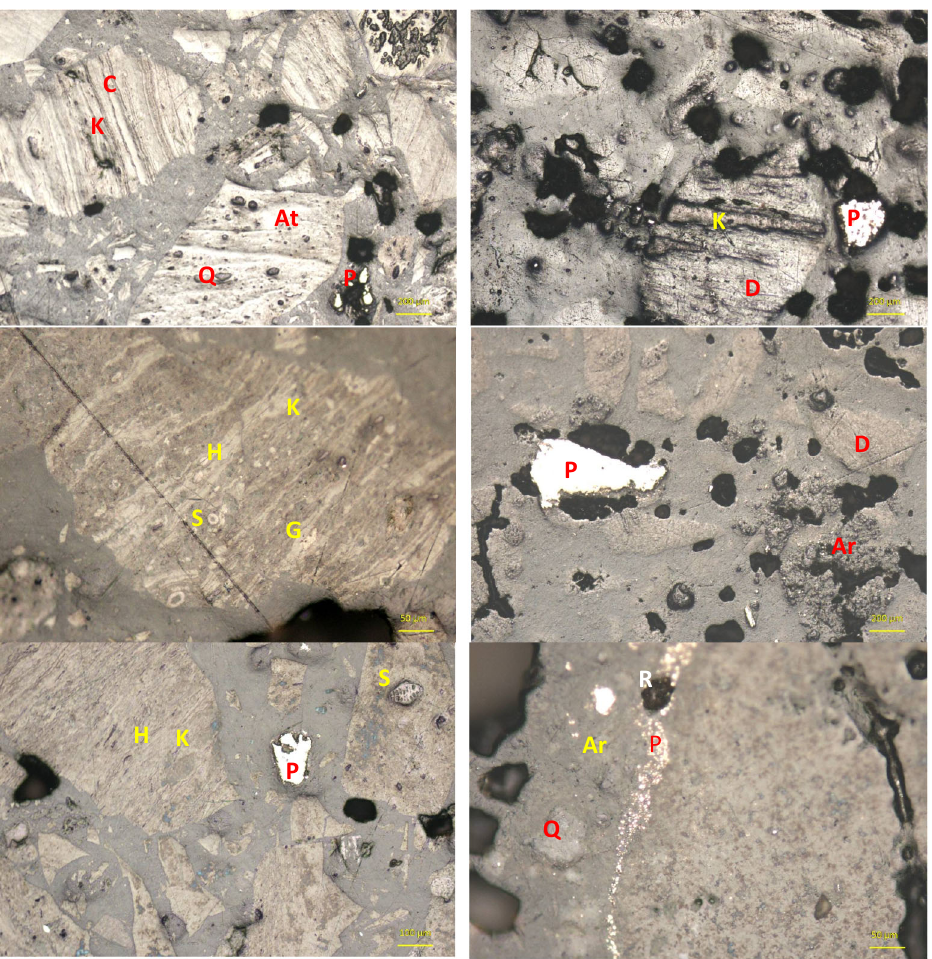
Fig. 1 Under reflecting light microscope, the polished coal samples showing P, pyrite; Ar, argilite; Q, quartz; S, sporinite; R, resinite; H, huminite; K, cutinite; G, gelinite; C, collotelinite; At, attrinite; D, ,